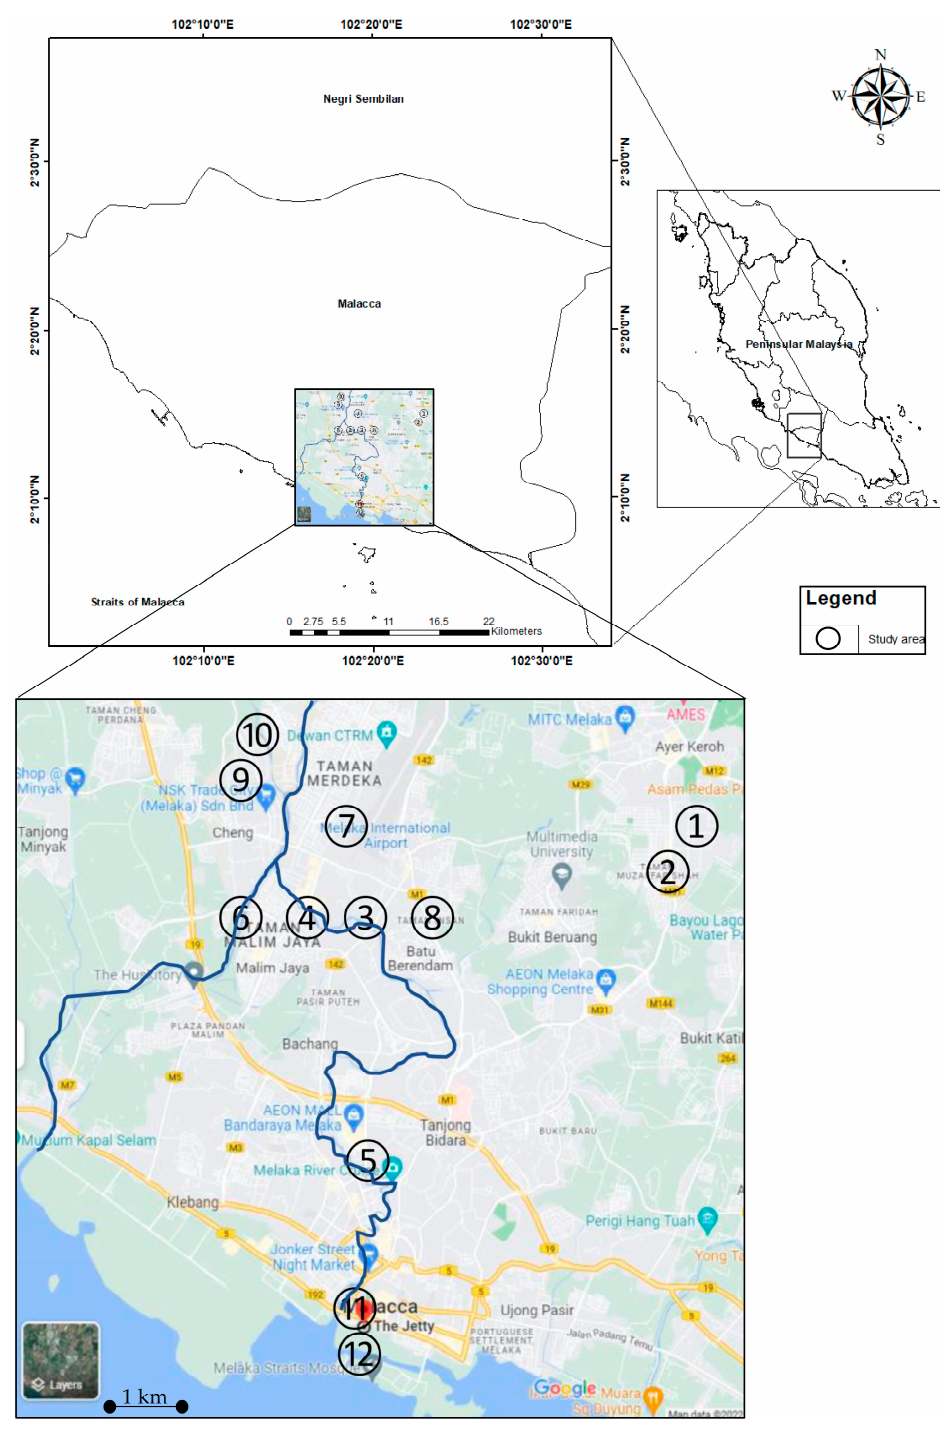
Figure 1. Map showing sampling sites in the Malacca area. Note: The sampling map was remade based on google.com/maps (accessed on 18 July 2022).